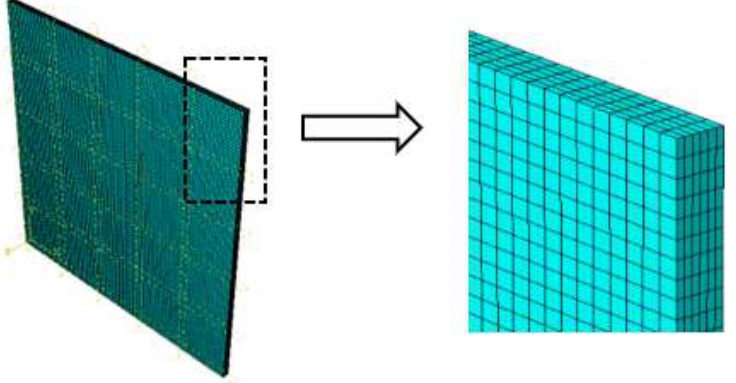
Figure 15. Finite element model: FE mesh and detail at corner.